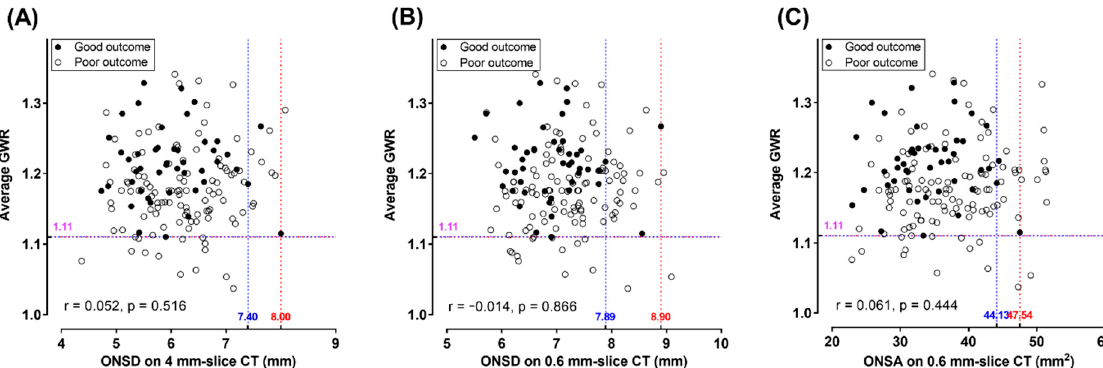
Figure 4. Scatter plots showing the distribution of the average gray-to-white matter ratio and optic nerve sheath diameters on 4 mm-slice CT ( A ) and 0.6 mm-slice CT images ( B ) or the optic nerve sheath area ( C ) in the good and poor neurological outcome groups. The Pearson correlation coefficients (r) and p values are indicated. The red dotted line indicates the cutoff value with a 100% specificity for determining a poor neurological outcome. The blue dotted line indicates the best cutoff value that was selected by the authors. GWR, gray-to-white matter ratio; ONSD, optic nerve sheath diameter; ONSA, optic nerve sheath area.